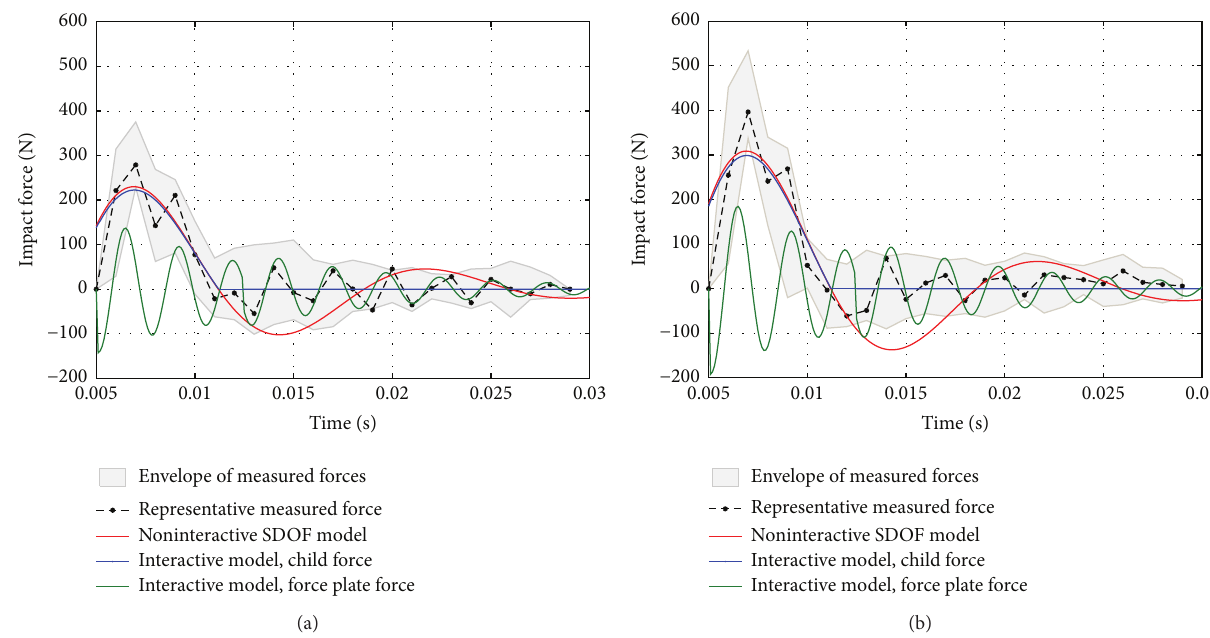
Figure 7: Comparison of the impact force experienced by a child, with and without taking into account the interaction with the force plate for tests T02 (a) and T04 (b).